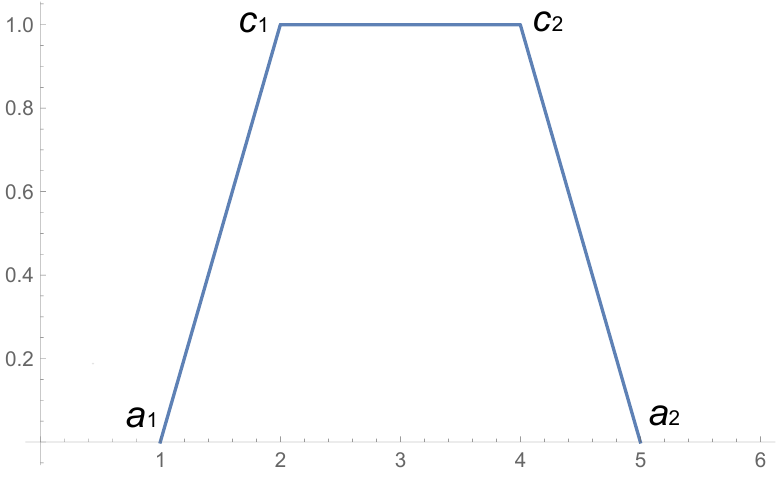
Figure 1. Trapezoidal membership function Π